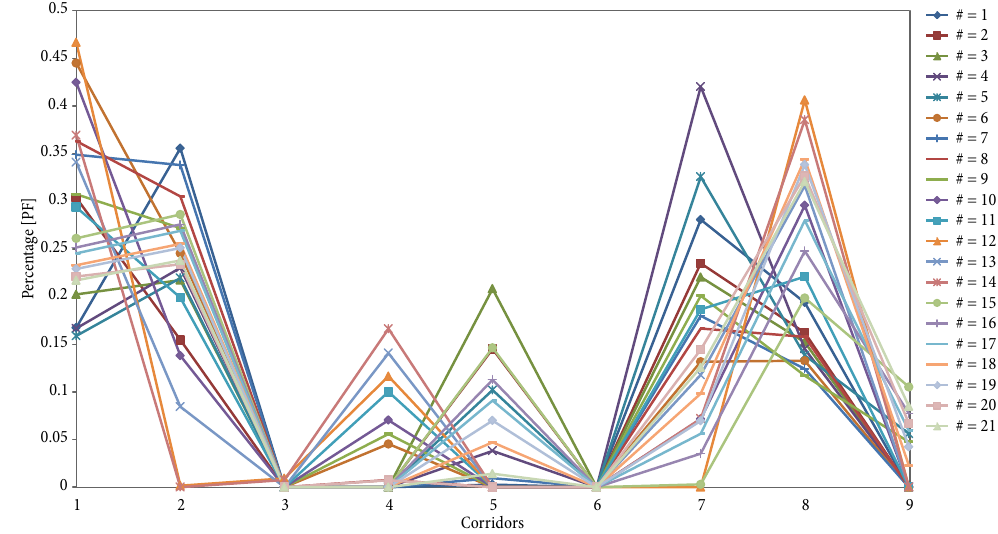
Fig. 4. Comparison of percentage flow on each corridor for different number of track